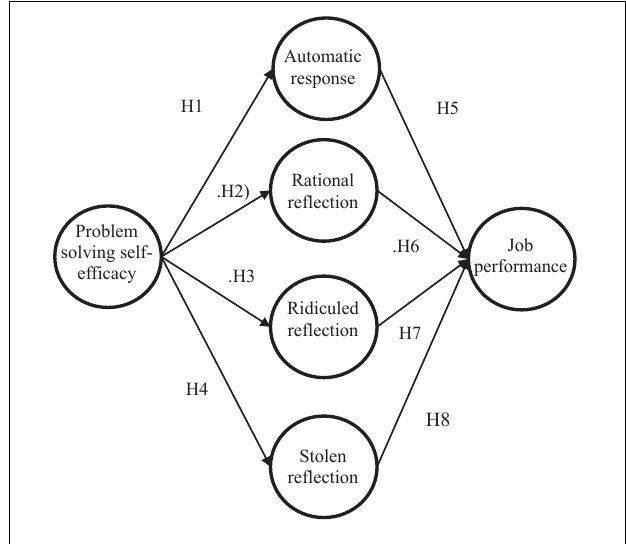
FIGURE 1 | Research